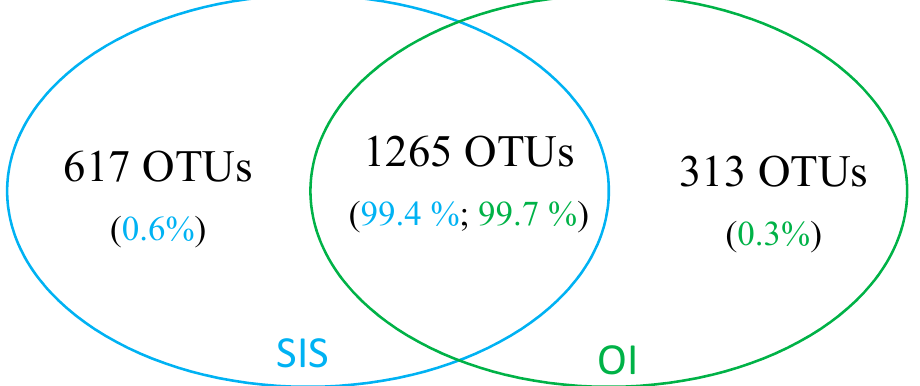
Figure 1. Venn diagram showing the number of shared and unique intestinal bacterial OTUs between the SIS and OI genetic lines of whiteleg shrimp raised in an indoor facility. Also shown is the proportion of sequence reads for each category.